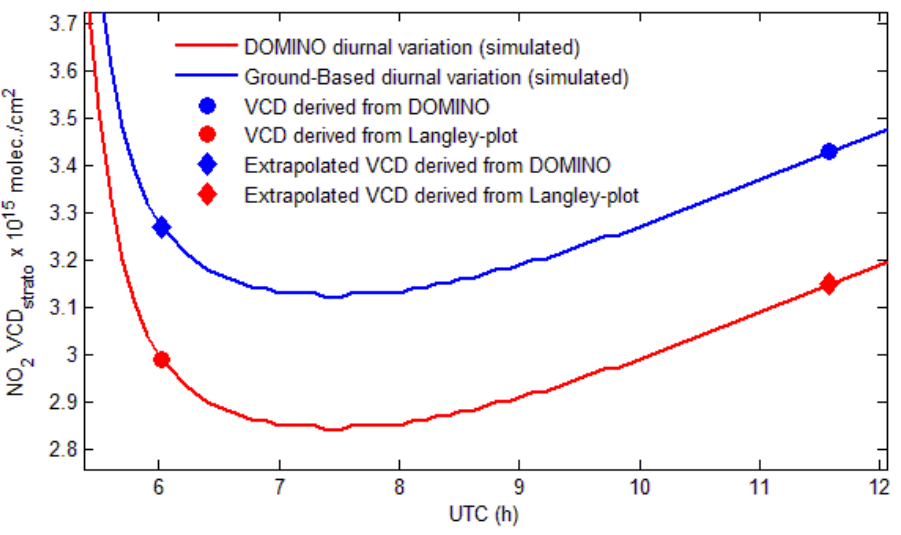
Figure 4. Comparison of the stratospheric NO derived from OMI on 6 October 2011. The AM diurnal variation was simulated using the PSCBOX